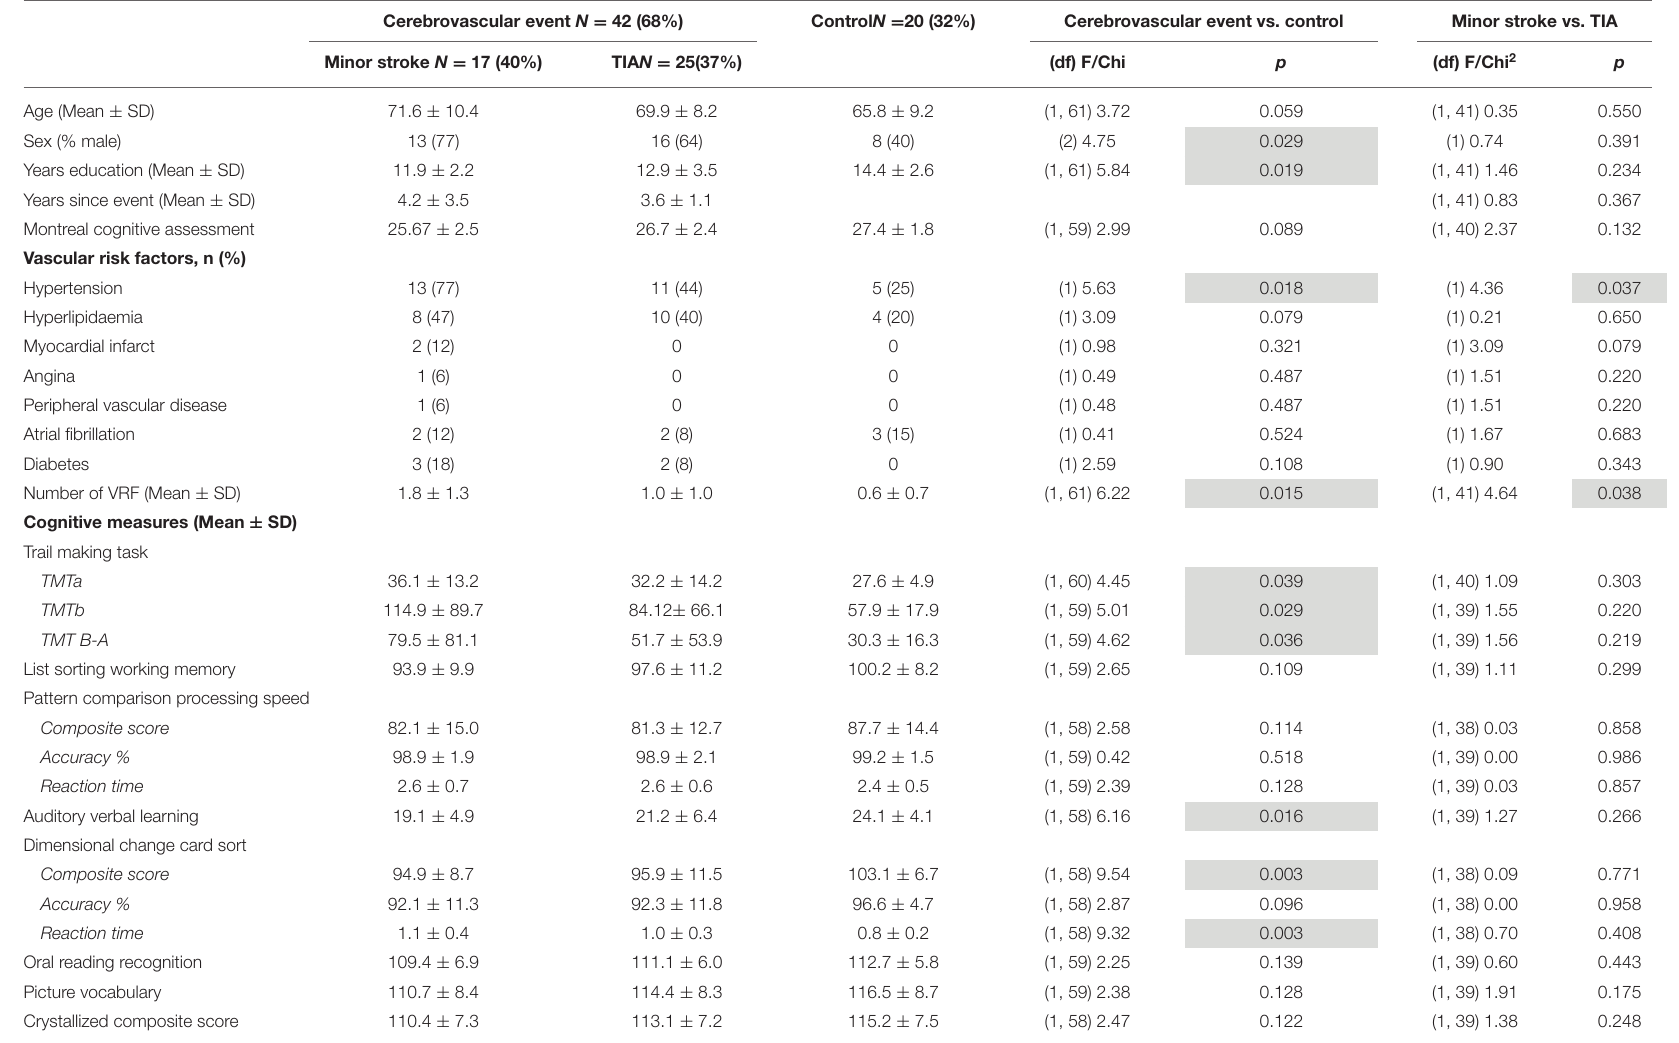
TABLE 3 | Group differences in demographics and cognitive ability. Cerebrovascular event N = 42 (68%) Control N = 20 (32%) Cerebrovascular event vs. control Minor stroke vs.